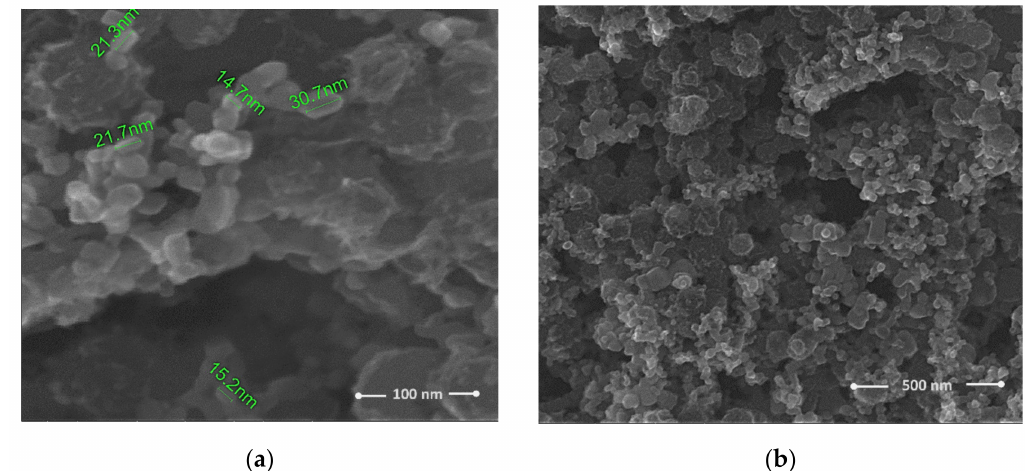
Figure 4. Scanning electron micrographs of the CNHox/TiO 2 /PVP at the 1:1:1 w/w/w ratio: ( a ) × 600,000 magnification and ( b ) × 150,000 magnification.